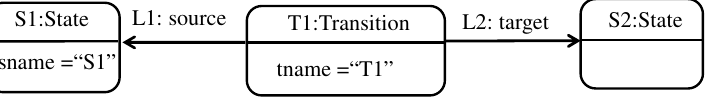
Figure 9. A typed attributed graph, typed over the ATG in Figure